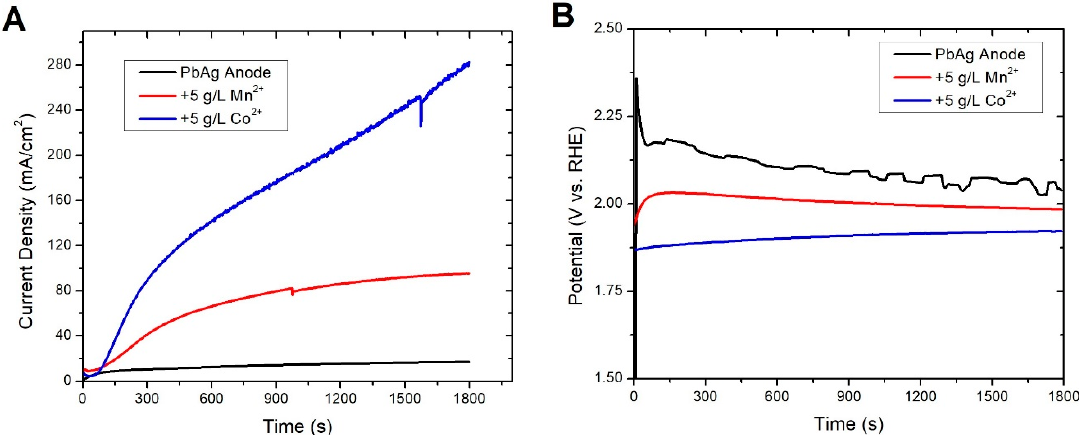
Figure 4. ( A ) Chronoamperograms at constant potential (2.06 V vs. RHE) and ( B ) chronopotentiograms under the three electrolyte conditions tested, with the Co-containing electrolyte in blue, Mn- containing electrolyte in red, and the PbAg anode without any water oxidation catalytic metal additives in